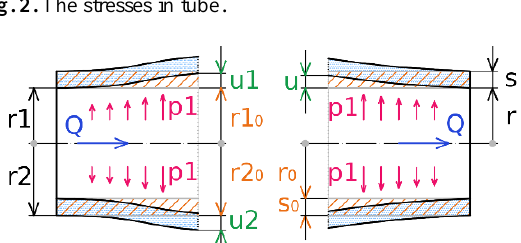
Fig. 2. The stresses in tube .